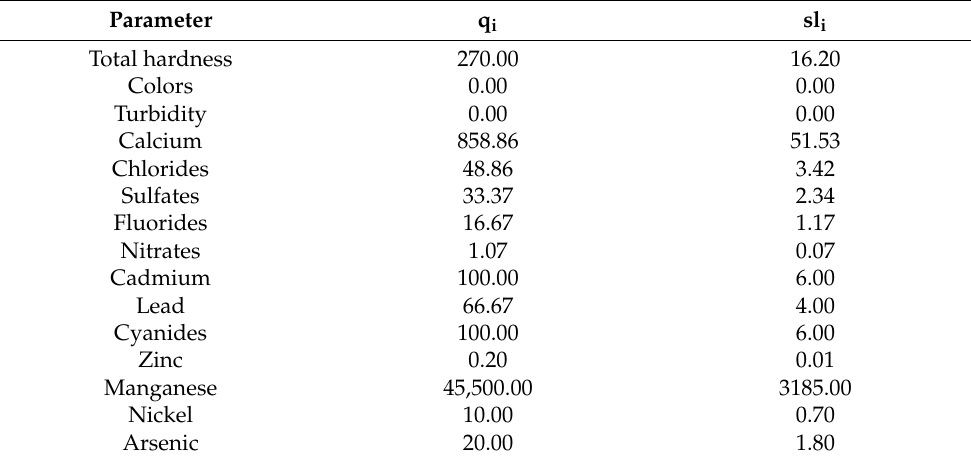
Table 8. Summary of the outcomes of the development of the water quality indices using untre- ated